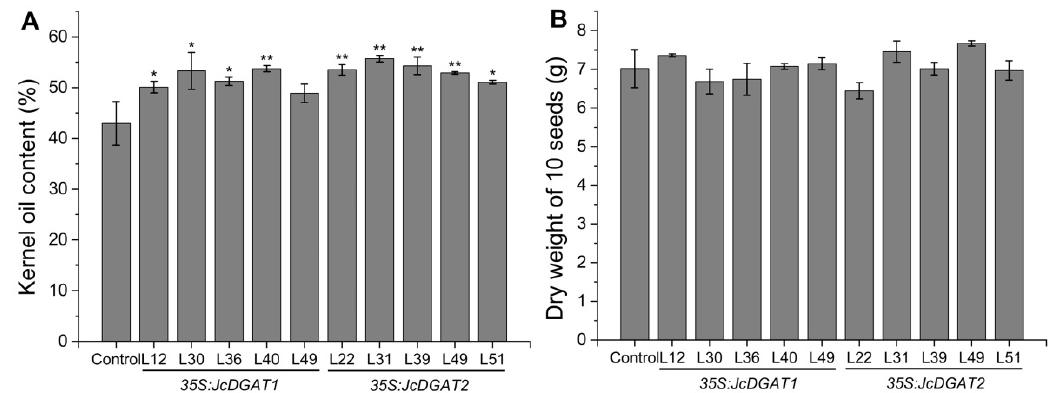
Figure 3. Seed kernel oil contents and dry weights in control and 35S:JcDGATs transgenic lines. ( A ) Total kernel oil content. ( B ) Dry weight of 10 seeds. The values are presented as the means ± standard deviations of three independent biological replicates. The student’s t-test was used for statistical analyses. * p ≤ 0.05, ** p ≤